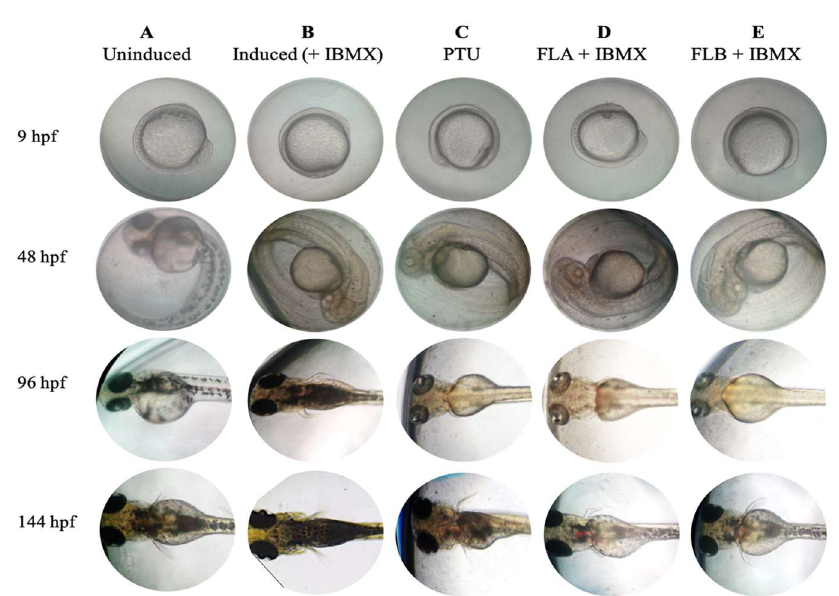
Figure 6. Phenotype-based melanogenesis inhibition of chalcone derivatives on zebrafish model. Synchronized zebrafish embryos were collected and maintained with ( A ) embryo media with 0.1% DMSO (uninduced) and ( B ) IBMX (100 µ M) in embryo media with 0.1% DMSO (induced).